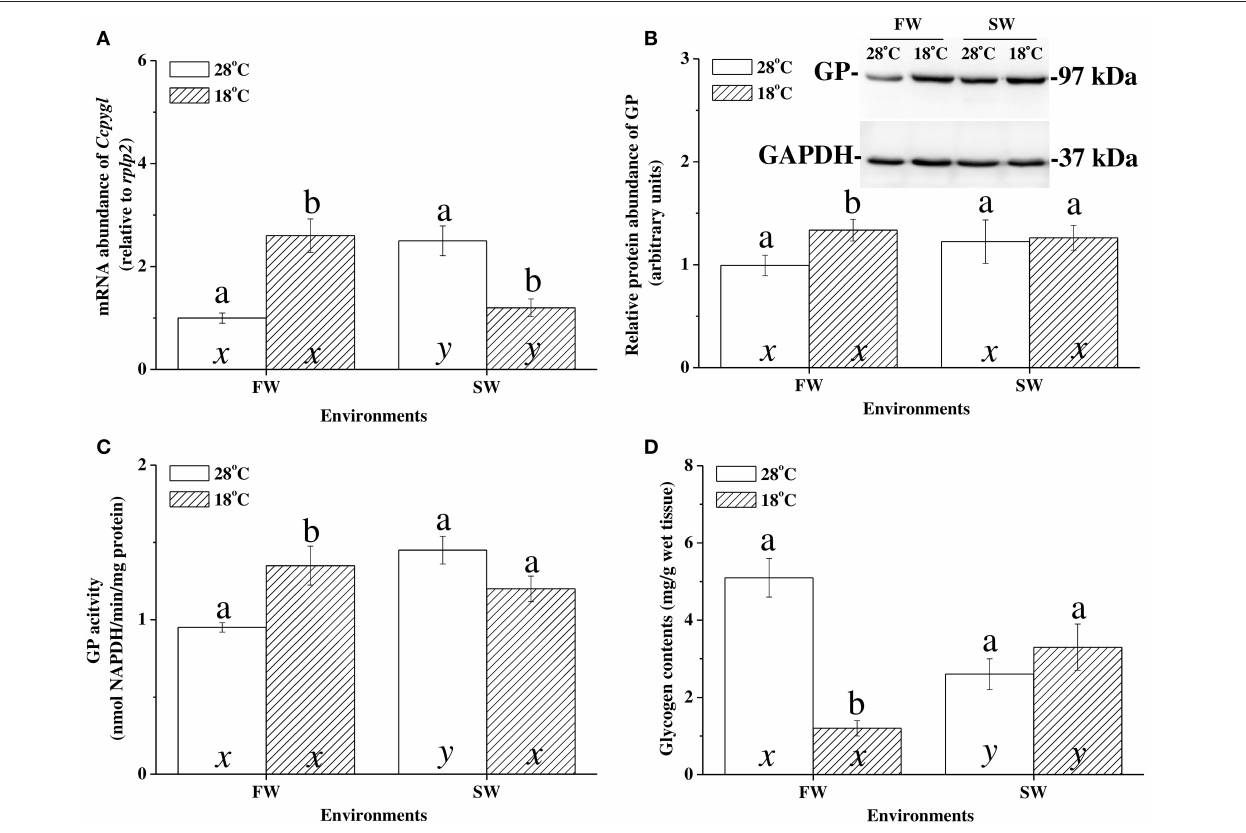
FIGURE 4 | The hypothermal acclimation experiments revealed the glycogen catabolism pattern in livers of freshwater (FW) and seawater (SW) milkfish after 1-week hypothermal stress. (A) mRNA expression of Ccpygl , (B) abundance of GP protein, (C) GP activity, and (D) glycogen content. Values are means ± SEM, n = 6. Different letters (a vs. b and x vs. y) indicate significant differences between the 28 ◦ C and 18 ◦ C group at the same salinity, and the FW and SW group at the same temperature, respectively. The TukeyHSD pairwise comparison followed the two-way ANOVA, P <